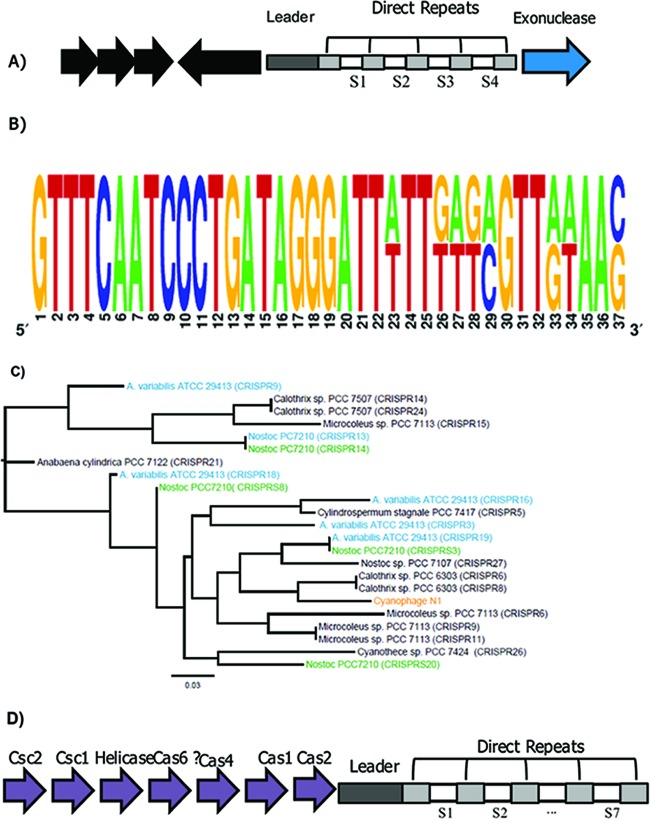
Characterization of the CRISPR in cyanophage N-1. (A) The CRISPR in cyanophage N-1 consists of five DRs (light gray boxes), four spacers (white boxes), and a leader sequence (dark gray box). The CRISPR array is surrounded by ORFs that putatively encode an exonuclease (blue arrows) or are hypothetical (black arrows). (B) A logo illustrating nucleotide differences in an alignment of the consensus DR from cyanophage N-1 and the consensus DR from CRISPR arrays 13 and 14 in Nostoc sp. strain PCC 7210. Differences are shown by placement of the letters for the nucleotides of Nostoc on the top and those for cyanophage N-1 on the bottom of the logo. (C) An unrooted neighbor-joining tree shows that the consensus DR in cyanophage N-1 (orange) is not most closely related to those found in its known hosts, Nostoc sp. strain PCC 7210 (green) and A. variabilis ATCC 29413 (light blue). Consensus DRs from other cyanobacteria, including those that are most closely related in Calothrix sp. strain PCC 6303, are shown in black. The scale bar represents 0.03 nucleotide change. (D) Schematic of CRISPR 8 in Nostoc sp. strain PCCC 7210. The CRISPR array consists of DRs (light gray boxes), seven spacers (white boxes), and a leader sequence (dark gray box). The CRISPR array is surrounded by CAS genes (purple arrows).